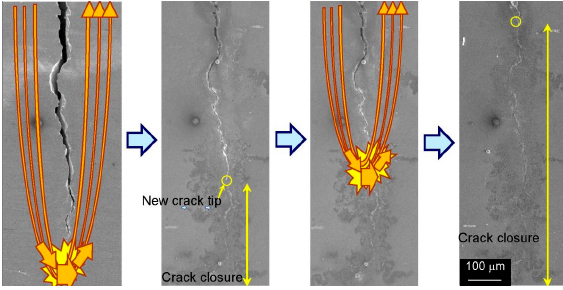
Figure 11. Closure of an entire fatigue crack by multiple applications of high-density electropulsing [128].